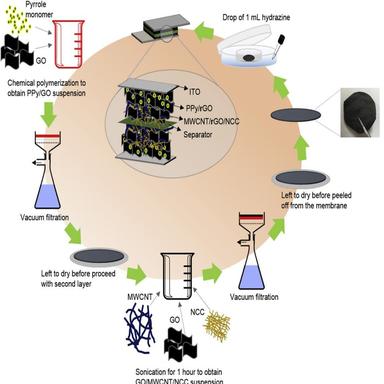
Schematic diagram illustrating the fabrication process of PPy/rGO|MWCNT/rGO/NCC bilayer film via in-situ polymerization and vacuum filtration methods to form a symmetrical supercapacitor.